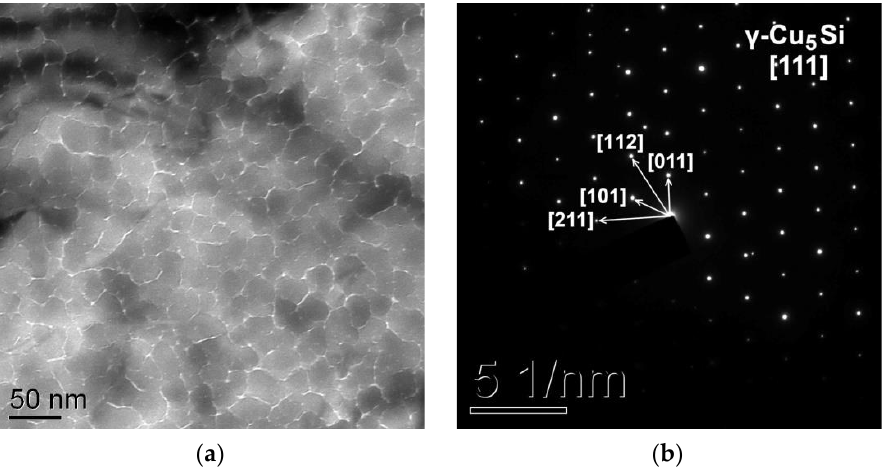
Figure 4. TEM image ( a ) and SAED pattern ( b ) obtained from the Cu/a-Si thin bilayer film after heating to 450 °C.